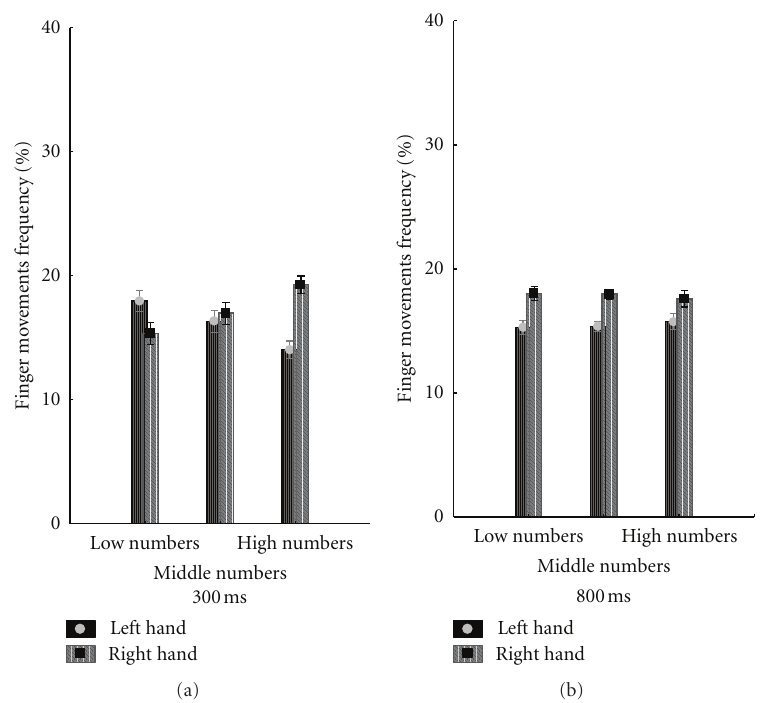
Figure 2: Influence of numerical magnitude on random movement generation. The graph plots the percentage of finger movements on the exposure to high (ranging from 7 to 9), middle (ranging from 4 to 6), and low numbers (ranging from 1 to 3). The interstimulus intervals were set up at 300 and 800 milliseconds (ms). Vertical bars indicate standard error. ∗ indicates significant di ff erences, P level = 0.05.